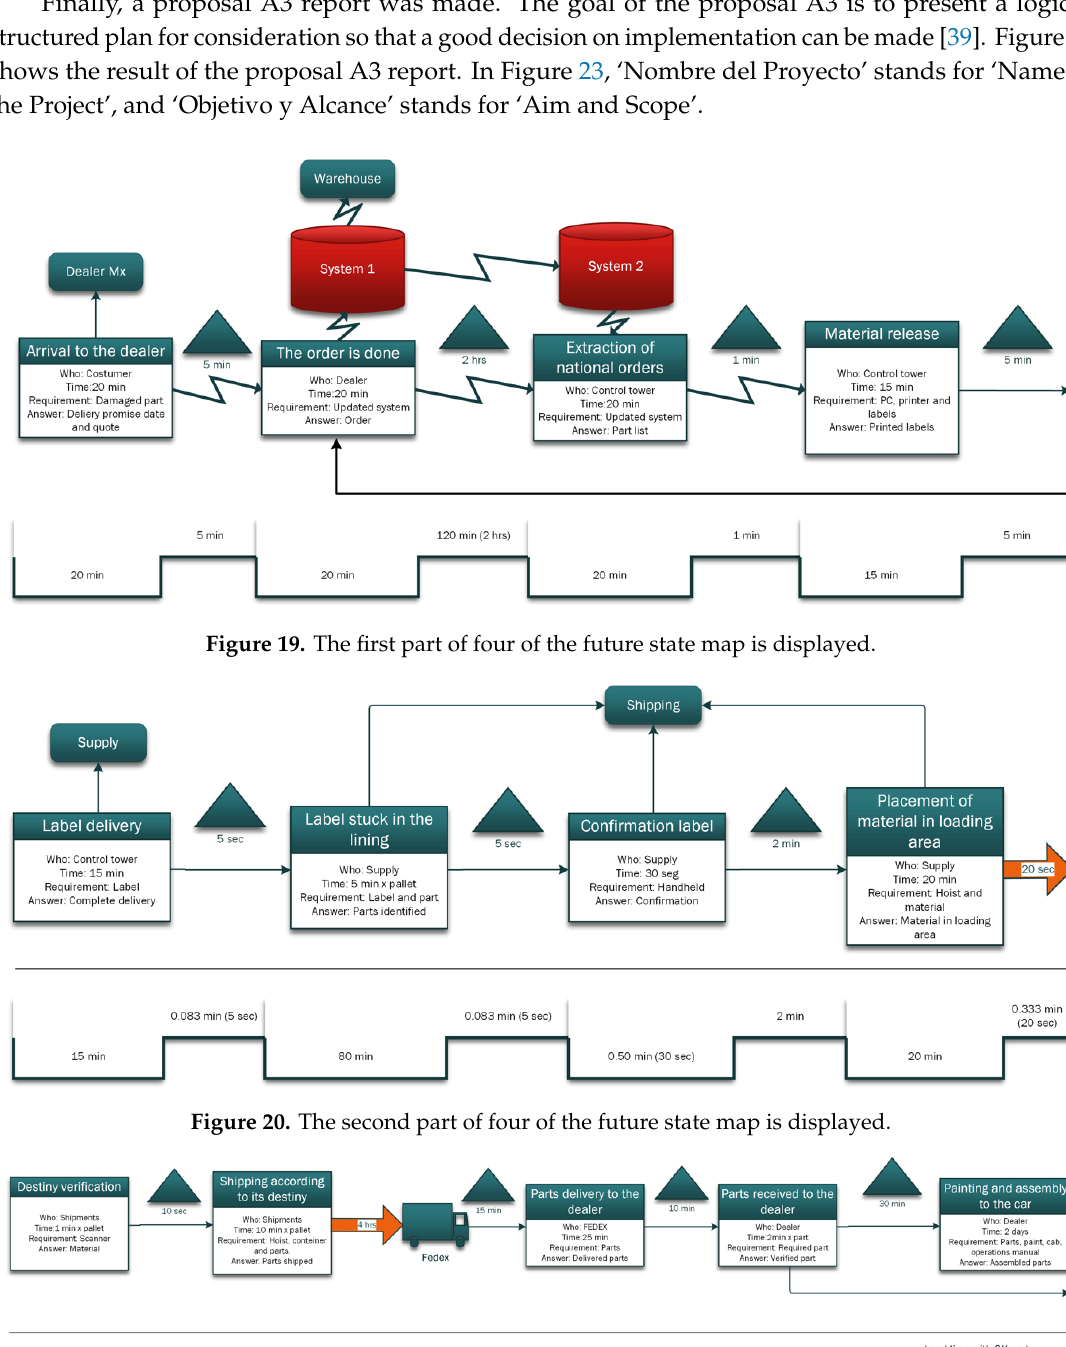
Figure 18. Second proposal for improvement.